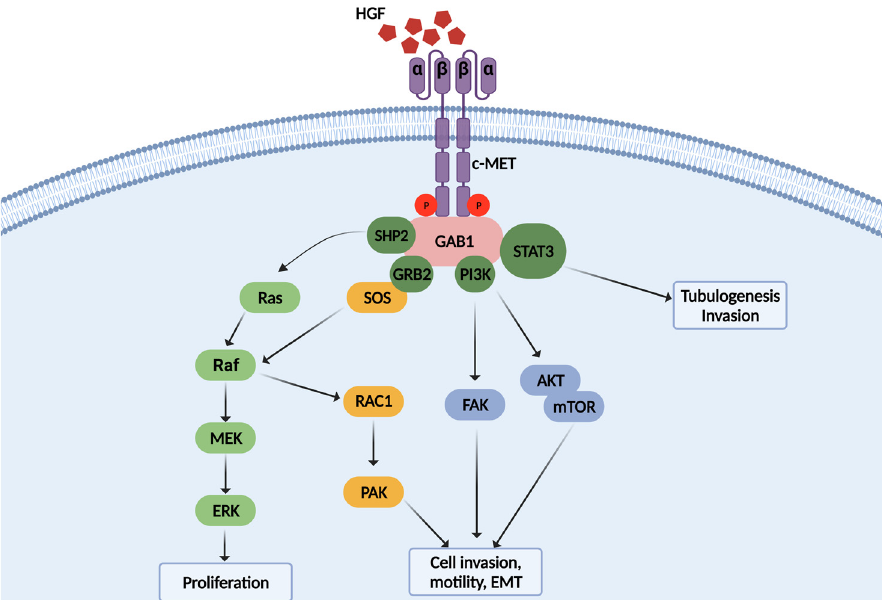
Figure 2. Signaling pathway of HGF/c-MET in cancers. Stimulation of c-MET by HGF induces activation of various down-stream signaling pathways, such as cell proliferation, invasion, and tubulogenesis.